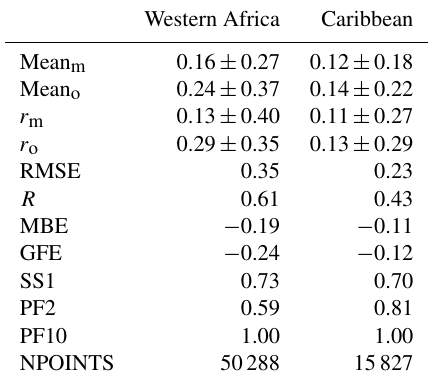
Fig. 1. The simulated dust surface concentration reaches on average up to 600 µgm − 3 at Dakar, indicating that the model captures the strong outflow event. Generally, two strong pre- cipitation areas are visible with one peak centered at 15 ◦ W with a monthly average of 20 mmday − 1 ; one peak area is